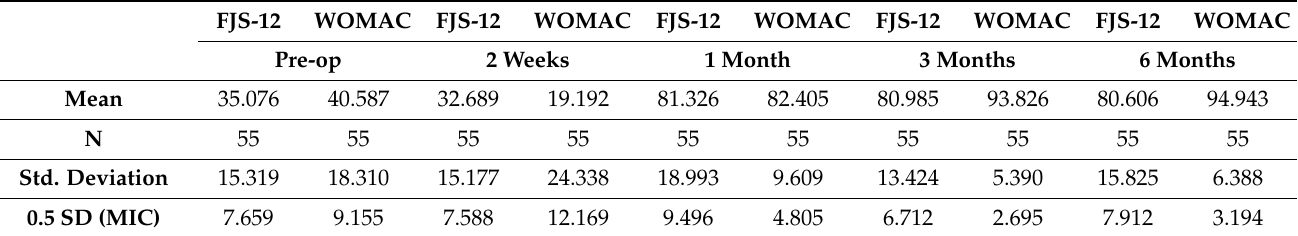
Table 1. Summary of results of WOMAC.